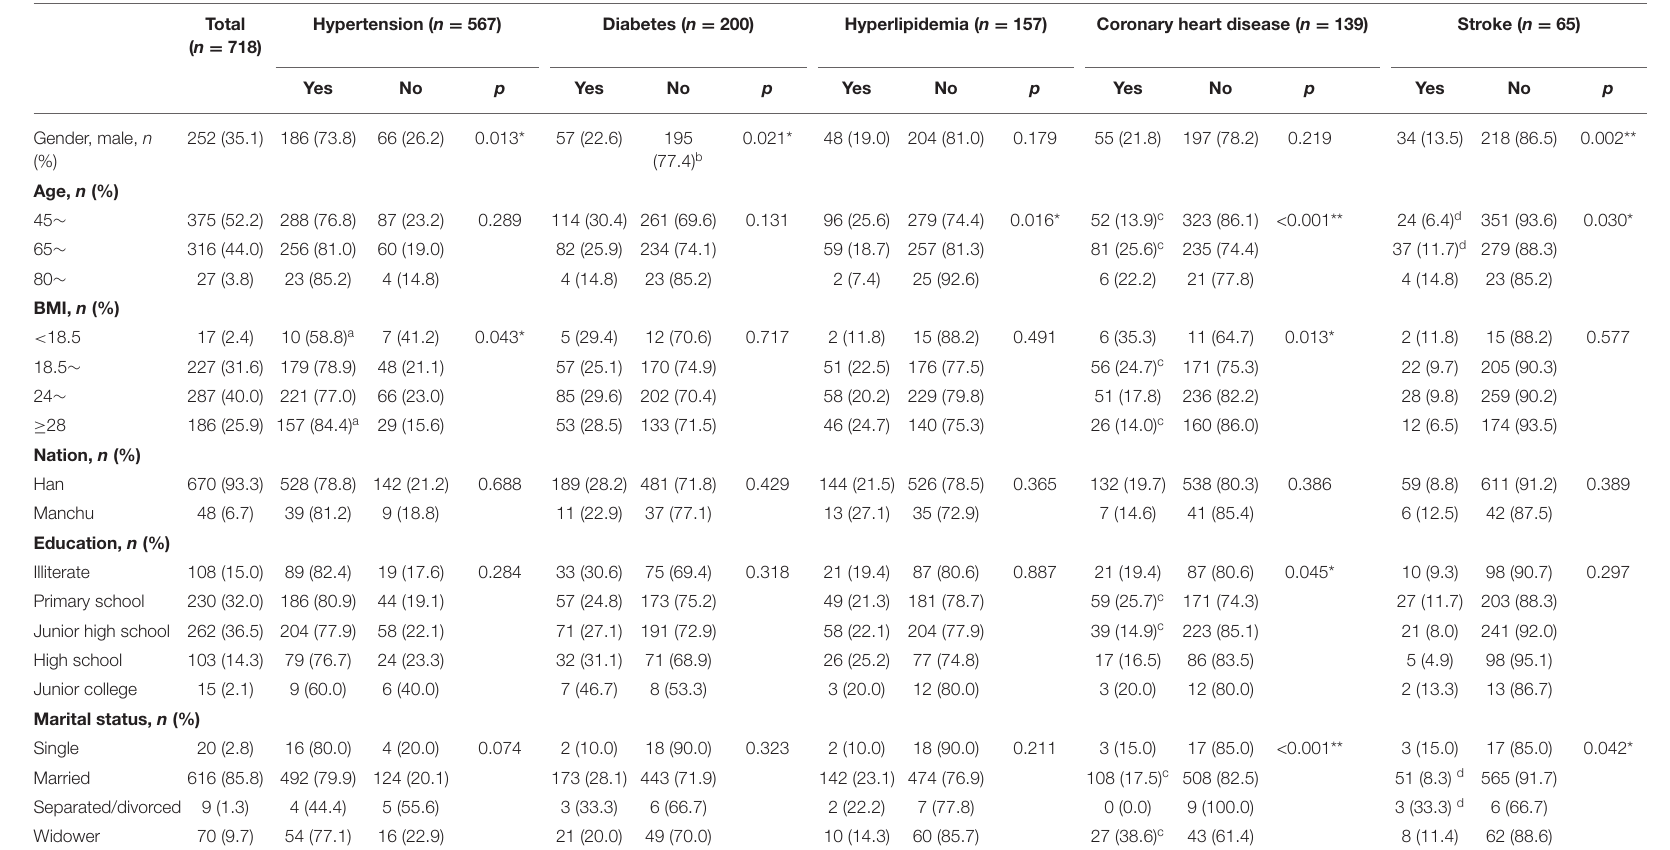
TABLE 1 | Demographic features and